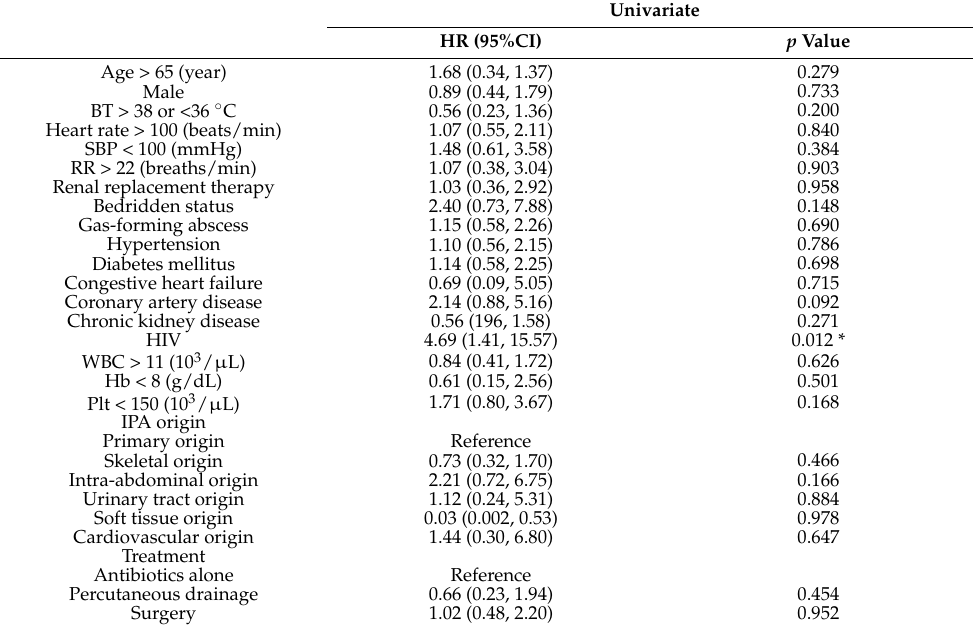
Table 7. Univariate analysis of predictors of recurrence with Cox proportional hazards